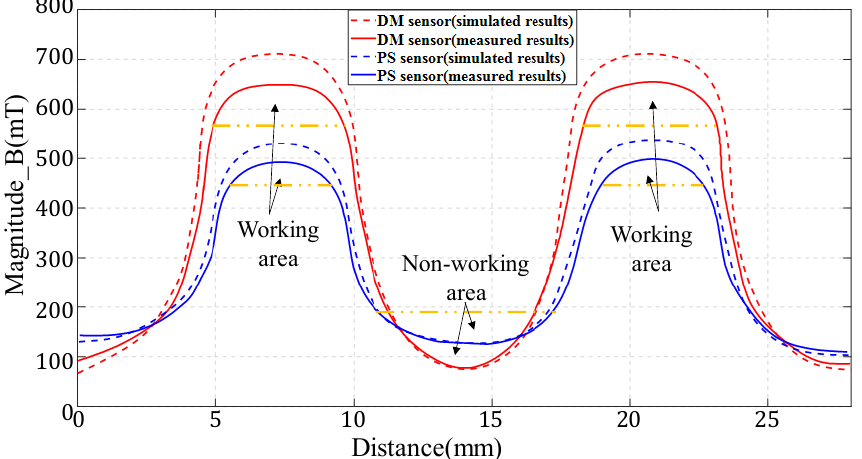
Figure 16. Distribution of magnetic field in air-gap of DM sensor and PS sensor. The length of the air-gap is 27 mm, and the magnetic field intensity is measured top-down.